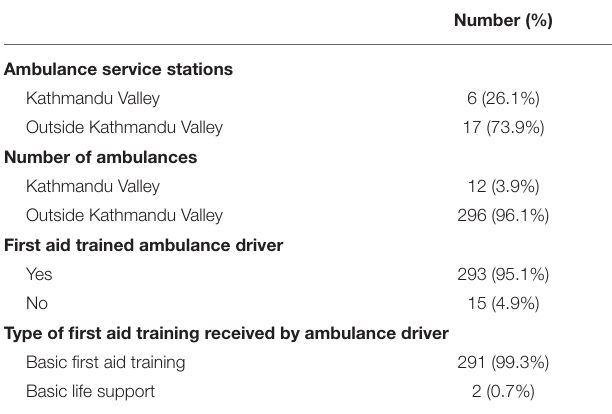
TABLE 2 | Ambulance services for